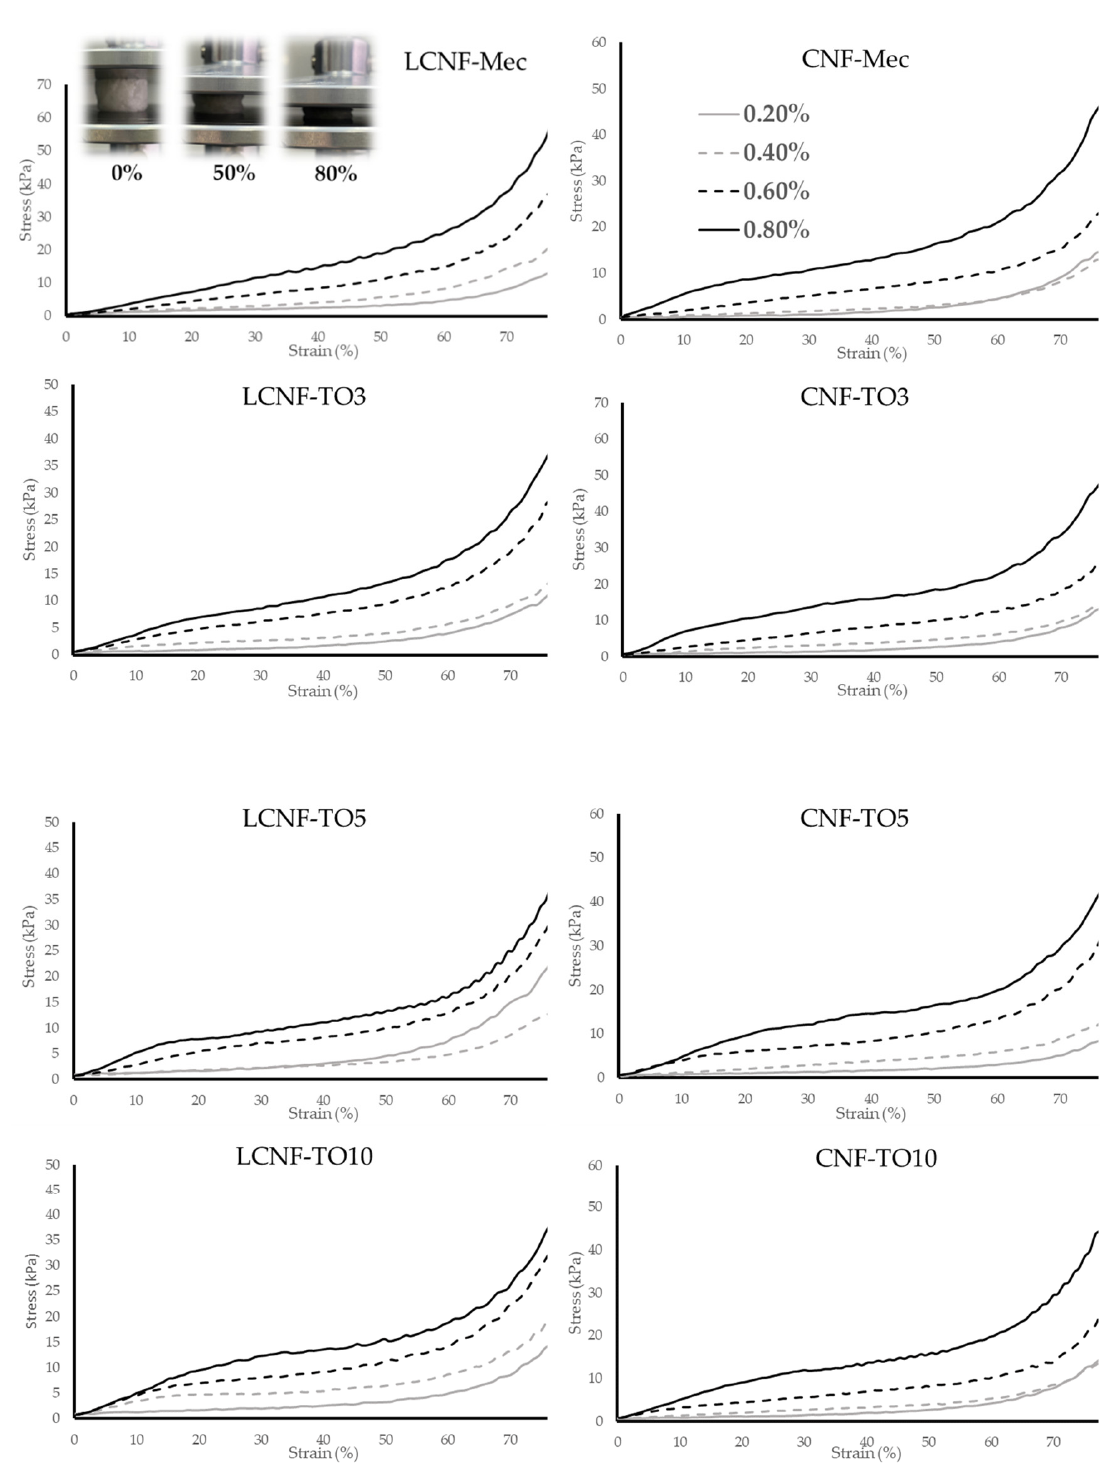
Figure 3. Stress–strain curves from the compression analysis of the different aerogels.